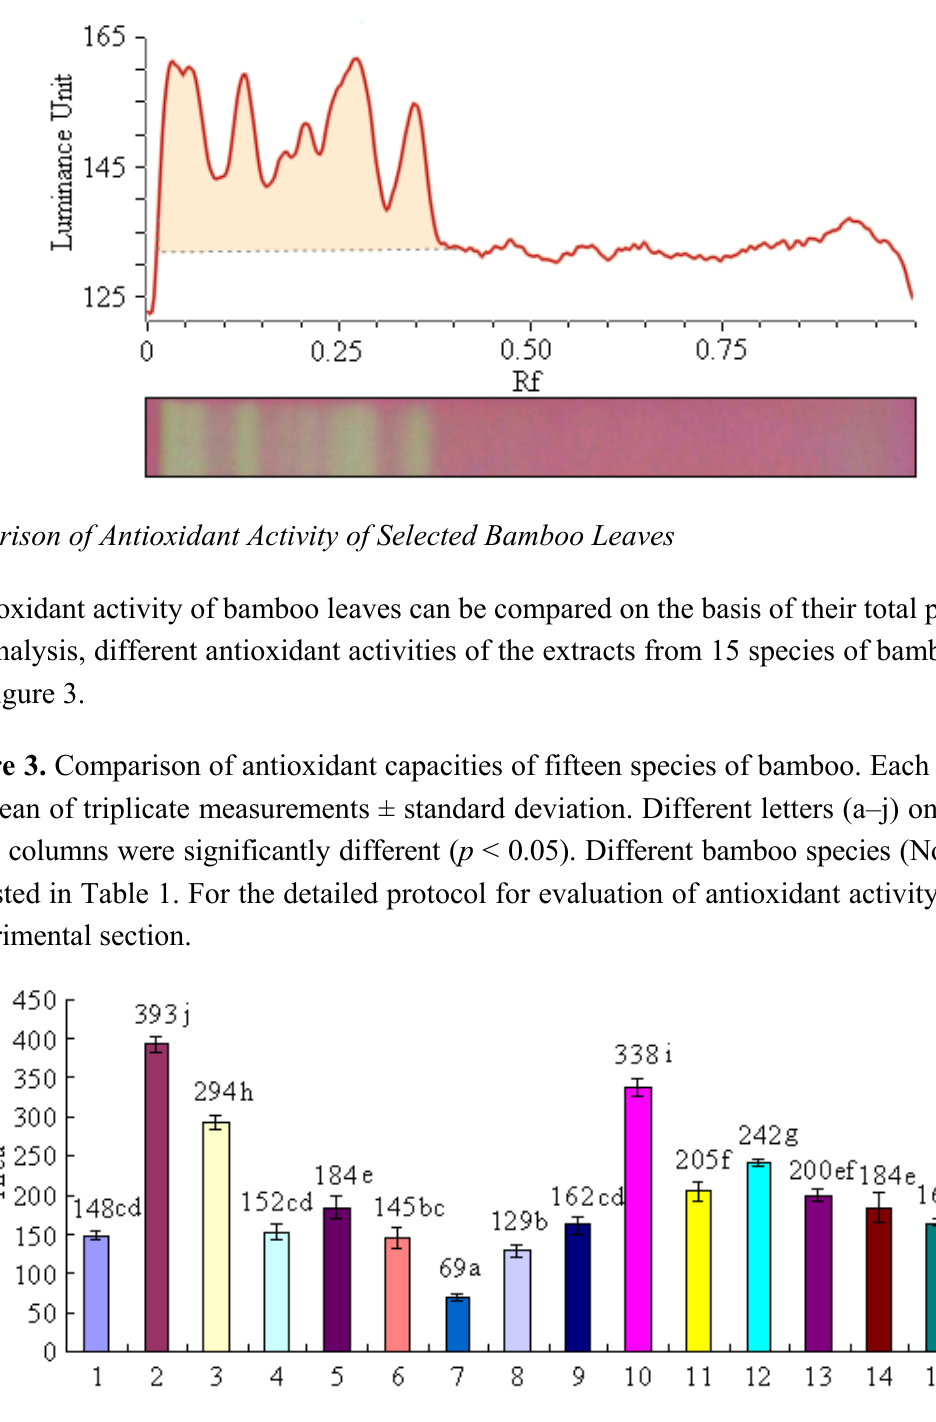
Figure 2. An example of TLC chromatogram and integration of peaks from leaf extracts of B. textilis McClure.